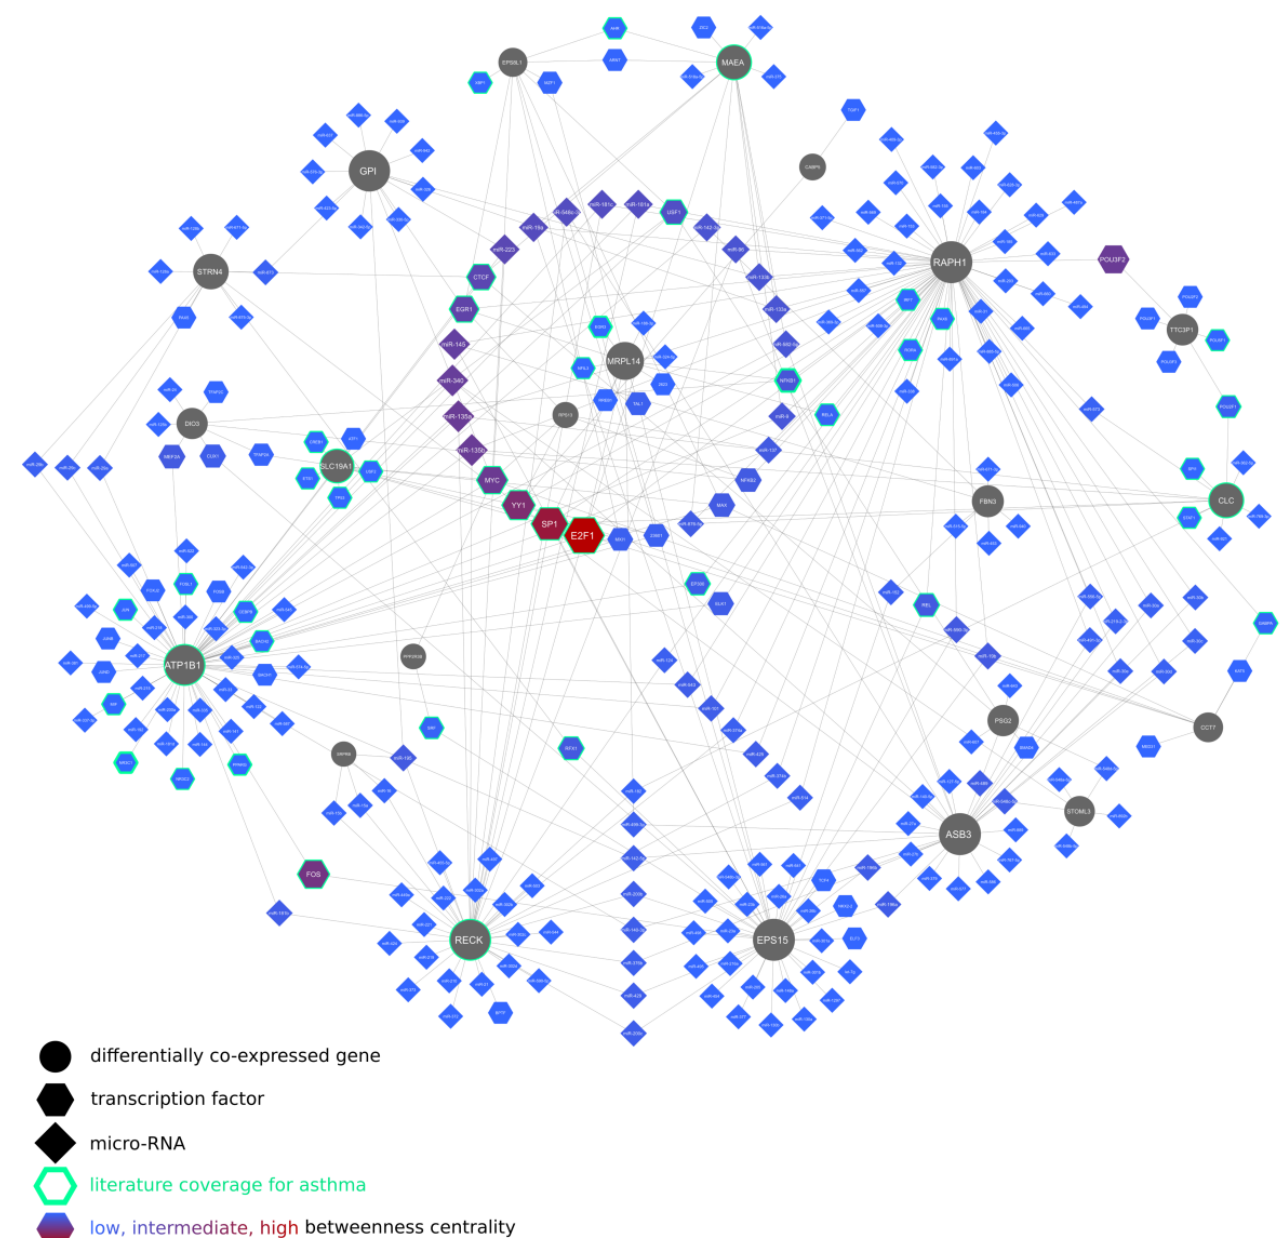
Figure 2. Regulatory network of miRNAs, transcription factors, and genes differentially co-expressed between eosinophilic and non-eosinophilic asthma patients in bronchial brush biopsy samples. 2.10. Cell-Type-Specific Histone Modifications Related to the Expression of Differentially Co-Expressed Genes A considerable proportion of the differentially co-expressed genes (15 out of 32, all up-regulated in the EA) matched differential expression patterns resulting from histone modifications H3K9ac and H3K27me3 characterized for human lung fibroblast hg19 [44] (Supplementary Table